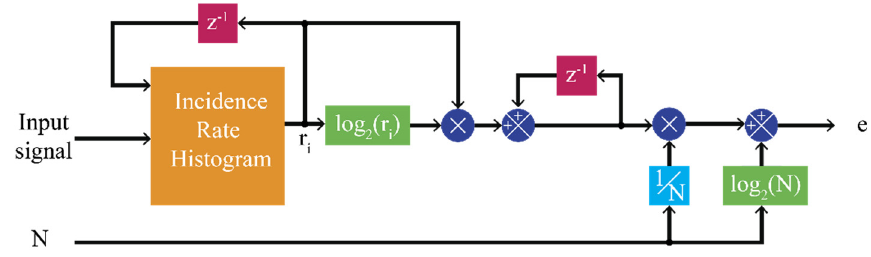
Figure 8. Entropy module.